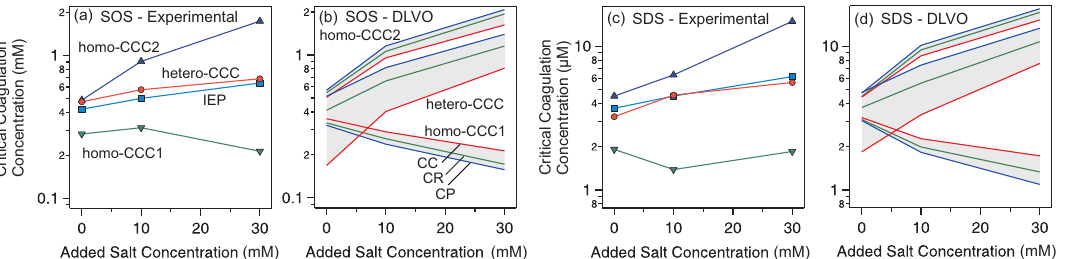
Figure 7. Critical coagulation concentration as a function of added salt for ( a , b ) SOS and ( c , d ) SDS. Homo-CCC1, homo-CCC2, hetero-CCC, and IEPs of AL particles are presented. The experimental data is shown in ( a ) and ( c ), while CCCs extracted from DLVO calculations including the effect of boundary conditions are shown in ( b , d ). Straight lines are used to connect the respective data